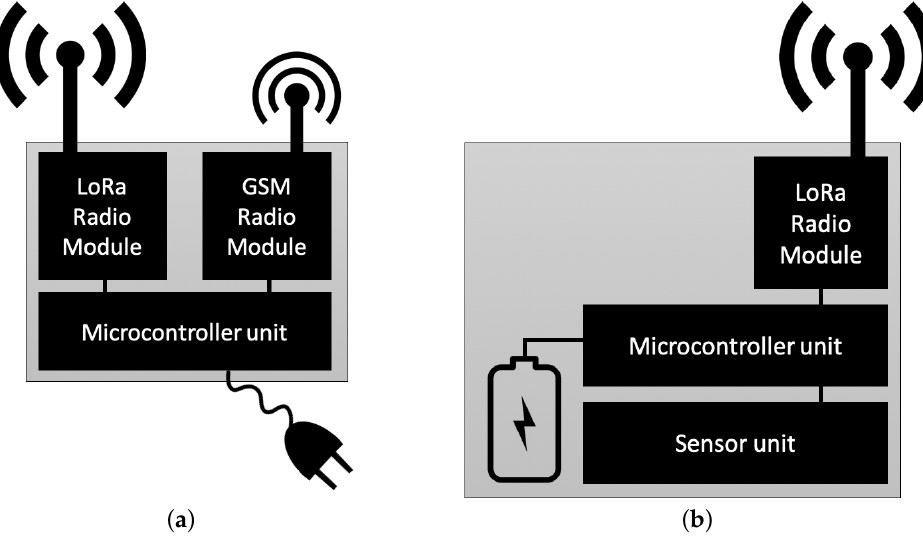
Figure 4. Architecture of ( a ) Gateway Node and ( b ) Sensor